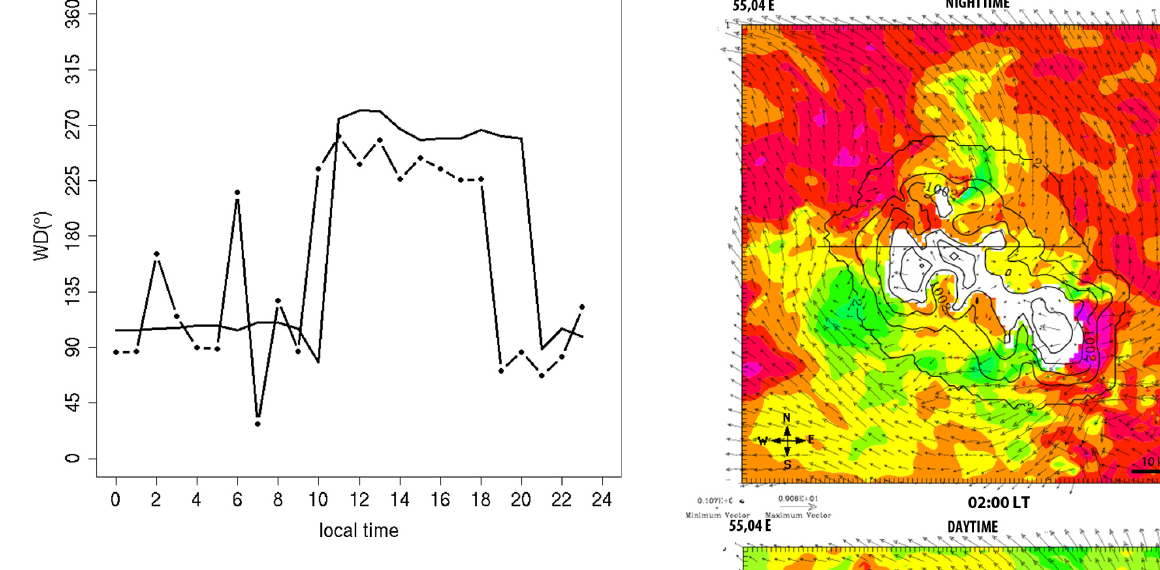
Fig. 8. Wind direction at POR (solid line: mean hourly observations over the austral winter 2007, dotted line: simulation ALIZ10).